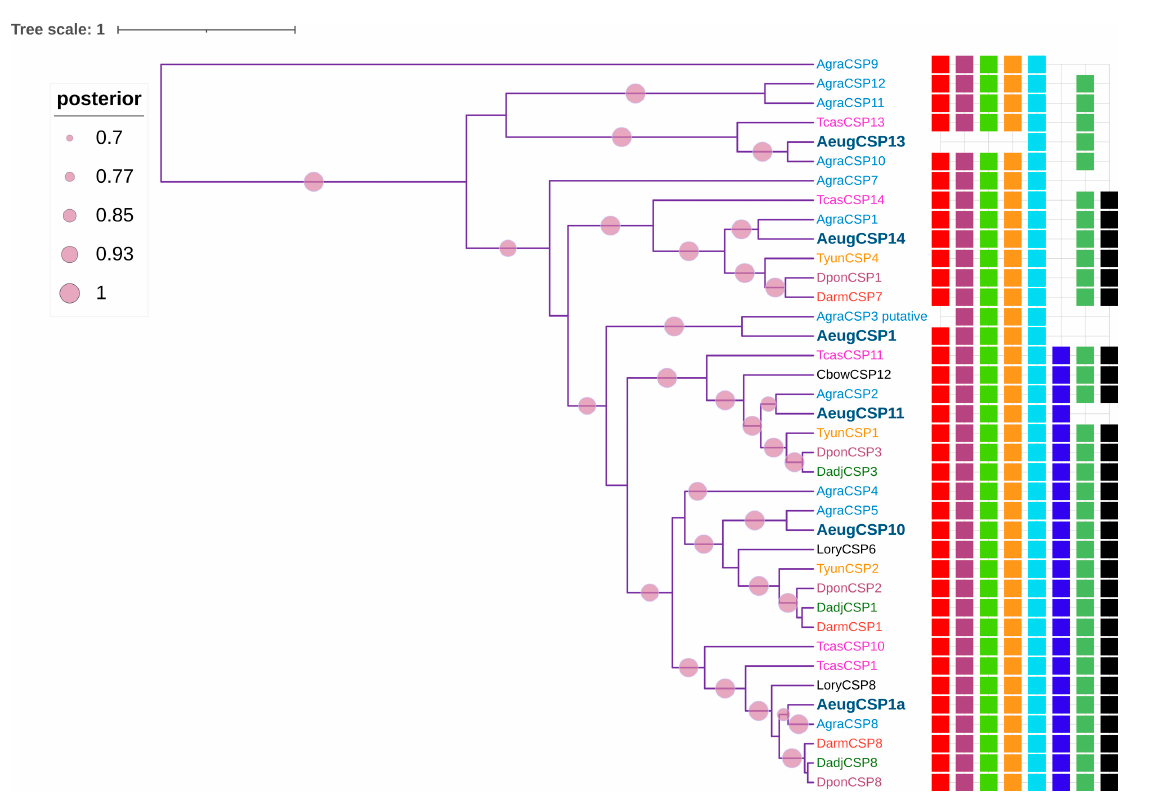
Table 2. Functional annotation of AeugCSPs, based on CDD/SPARCLE